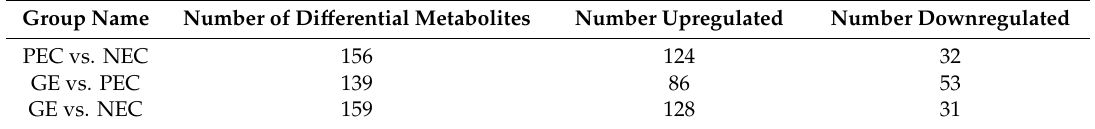
Table 1. Summary of differentially accumulated metabolites (DAMs) among NEC, PEC, and GE.